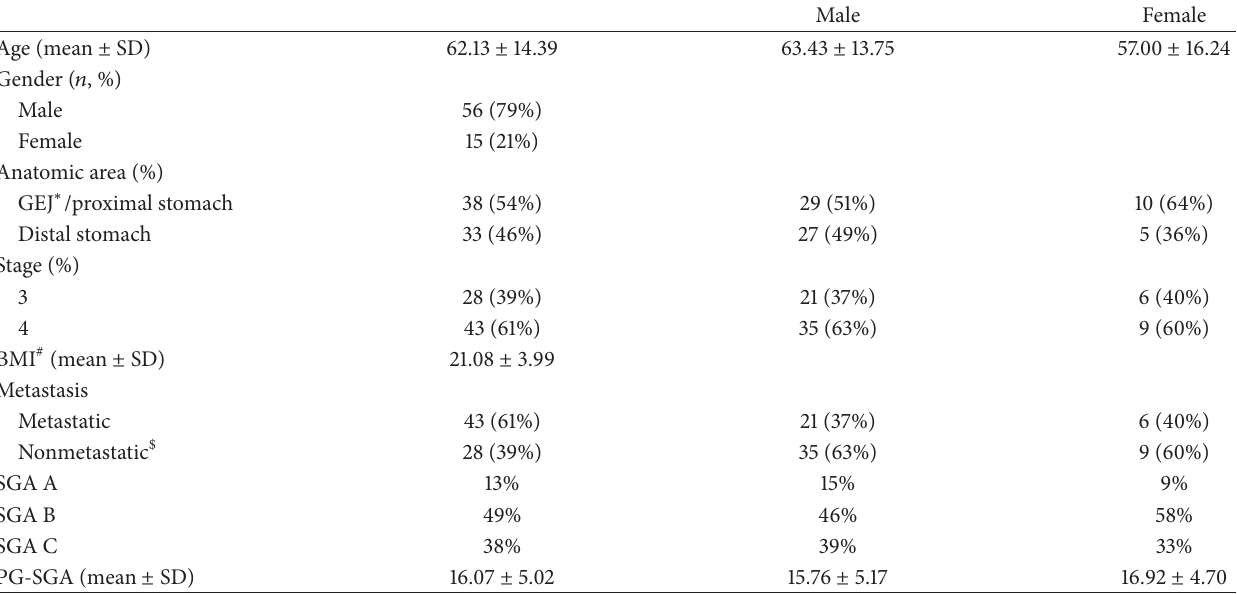
Table 1: General characteristics of the patients and